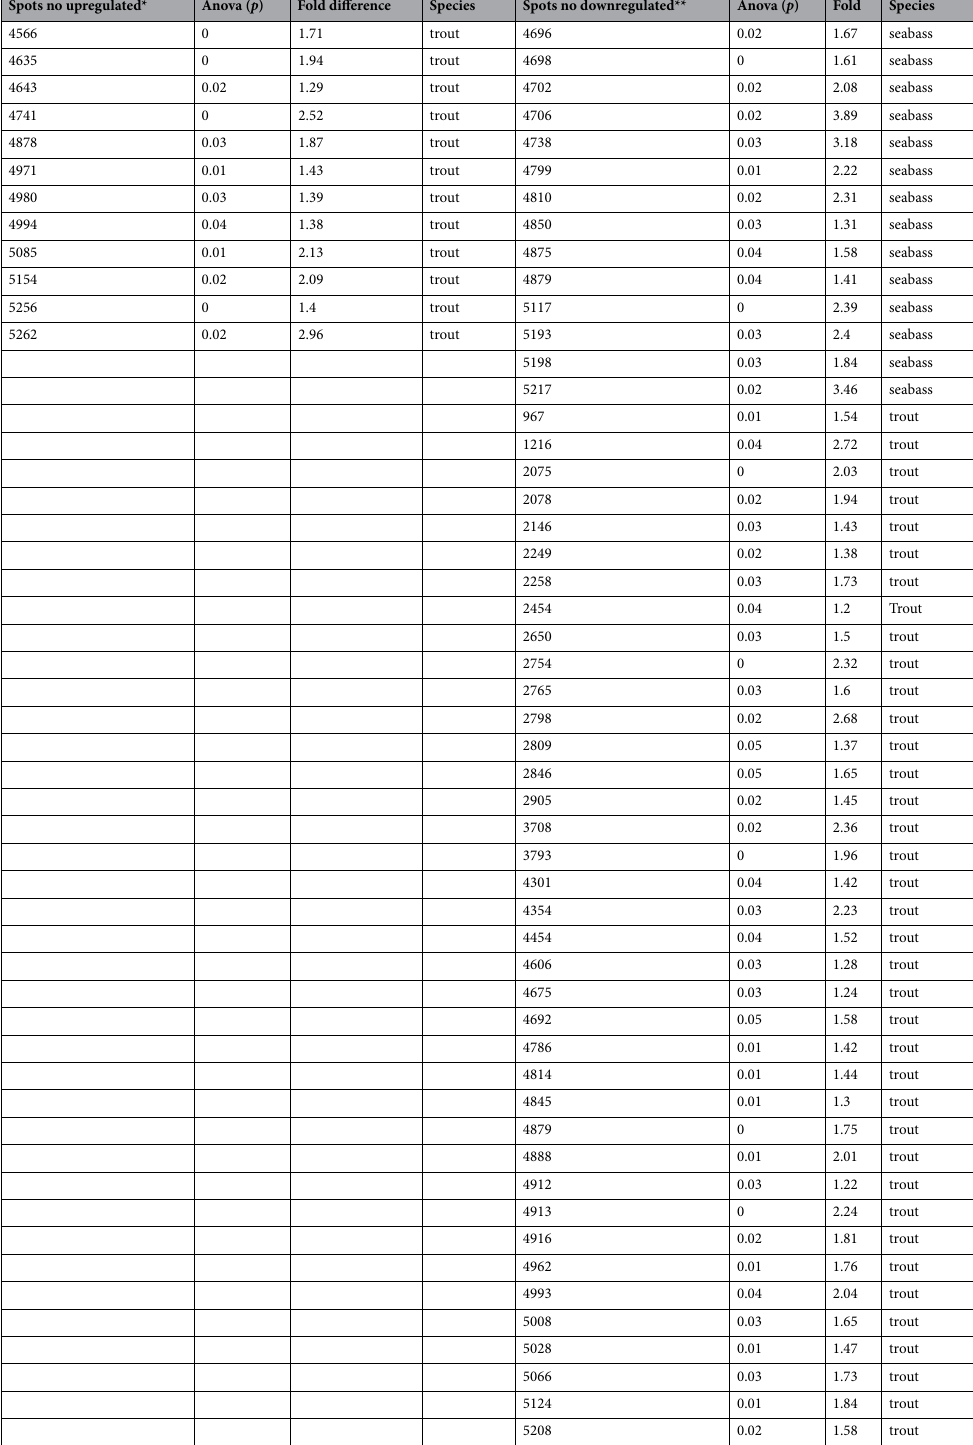
Table 2. Protein spots affected upregulated and downregulated by species (mean values for 4 to 5 determinations). *Significant difference (upregulated) at 25% TM inclusion compared to 0% TM inclusion ( p < 0.05) for gilthead seabream, at 50% TM inclusion compared to 0% TM inclusion ( p < 0.05) for European seabass and at 60% TM inclusion compared to 0% TM inclusion ( p < 0.05) for rainbow trout (t-test, p < 0.05). **Significant difference (downregulated) at 25% TM inclusion compared to 0% TM inclusion ( p < 0.05) for gilthead seabream, at 50% TM inclusion compared to 0% TM inclusion ( p < 0.05) for European seabass and at 60% TM inclusion compared to 0% TM inclusion ( p < 0.05) for rainbow